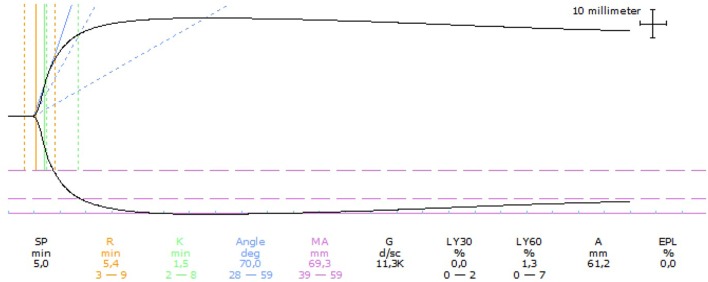
Thromboelastographic (TEG) tracing for case 4 performed on citrated whole blood. The TEG was considered hypercoagulable based on a normal reaction time (R), shortened clotting time (K), increased angle and maximum amplitude (MA), and increased clot strength (G). Dotted lines represent reference intervals and solid lines represent the test result.